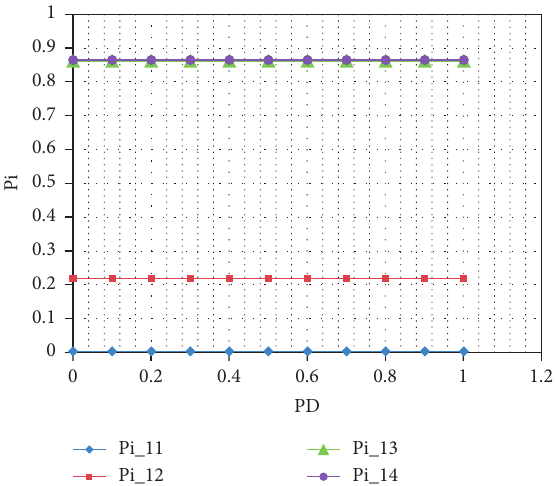
Figure 12: P I versus PD for 4 scenarios, showing constant contribution values of